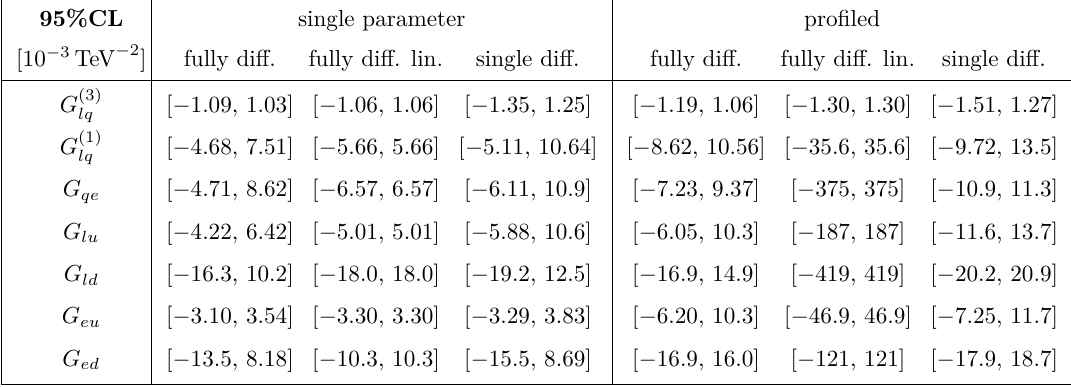
Table 12 . 95% CL projected bounds (in 10 − 3 TeV − 2 units) for the four-fermion operator coeffi- cients in the Warsaw basis at the 14 TeV LHC with L = 300 fb − 1 .